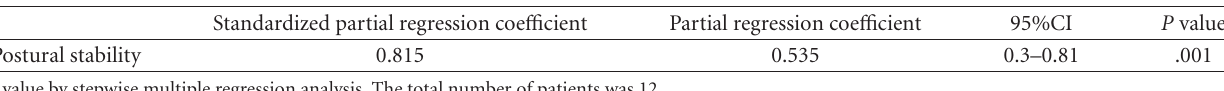
Table 2: Item in the motor examination of unified Parkinson’s disease rating scale associated with the gait domain of idiopathic normal pressure hydrocephalus grading